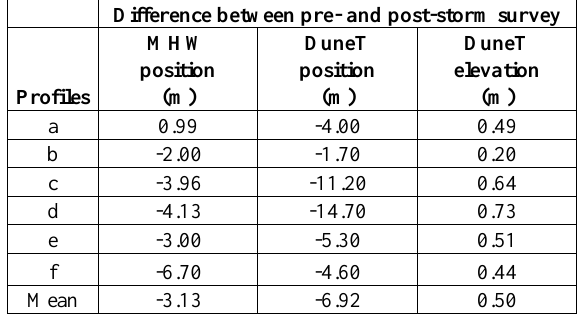
Table 2. Difference between the coastline detection of the MHW and DuneT proxies as a function of the profiles.